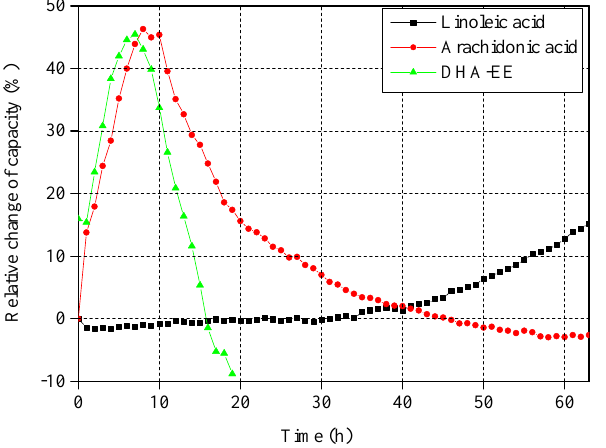
Figure 9. Time-dependent changes of capacity through the oxidation of fatty acids with various unsaturation ions (linoleic acid with 2, arachidonic acid with four and DHA-EE with six unsaturated bindings).